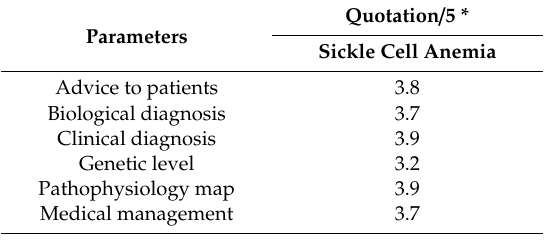
Table 2. Self-assessment of the level of knowledge of Congolese doctors on